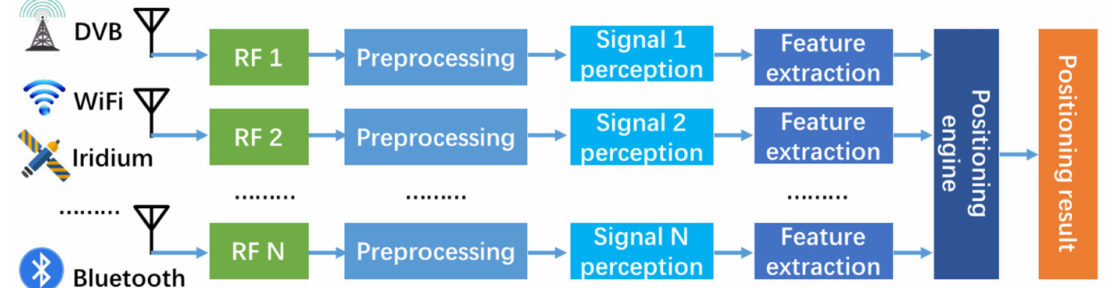
Figure 2. Structure diagram of traditional SOP positioning